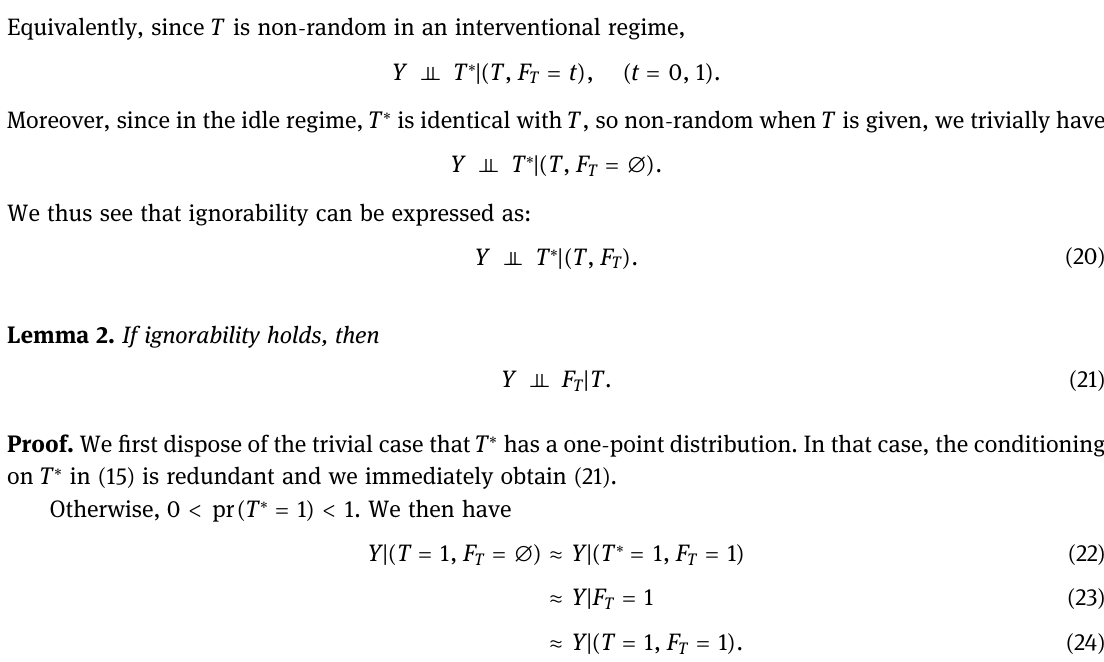
Figure 5: DAG representing T F T ⊥⊥ ∗ and Y F T T , T ⊥⊥ ∣( ) ∗